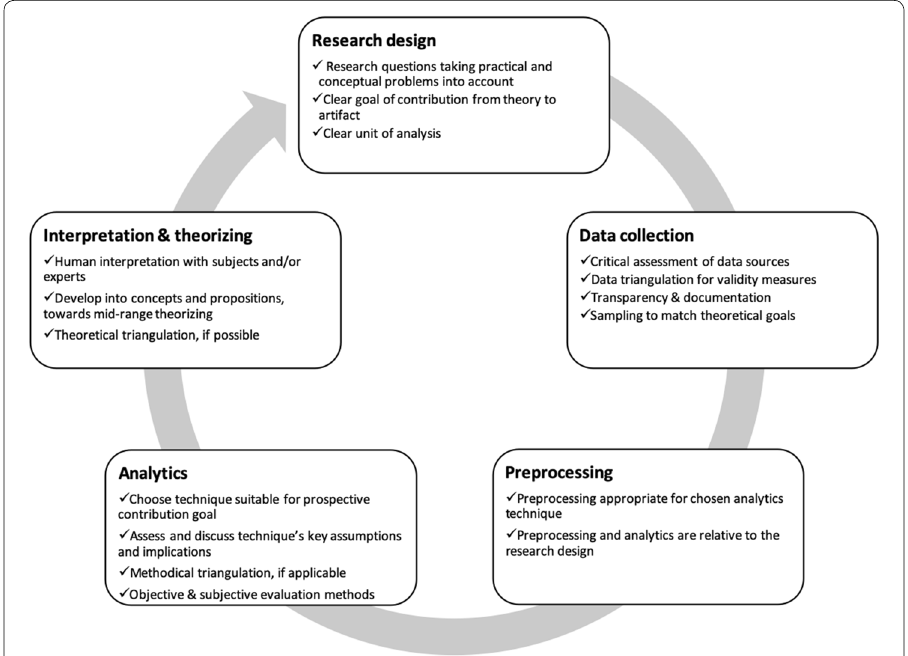
Fig. 1 Data science as a methodology for theoretical